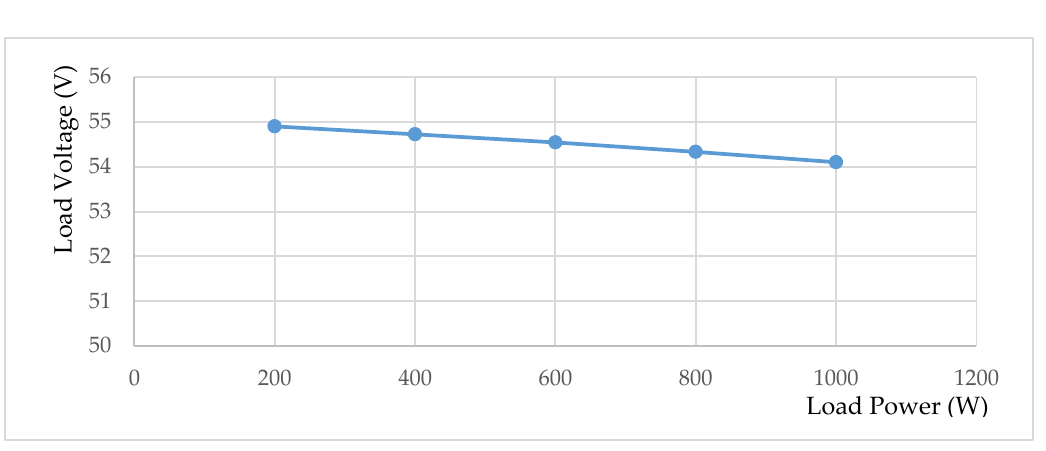
Figure 23. DC – DC converter stage output voltage ripple peak to peak measurement at V in = 400 V.